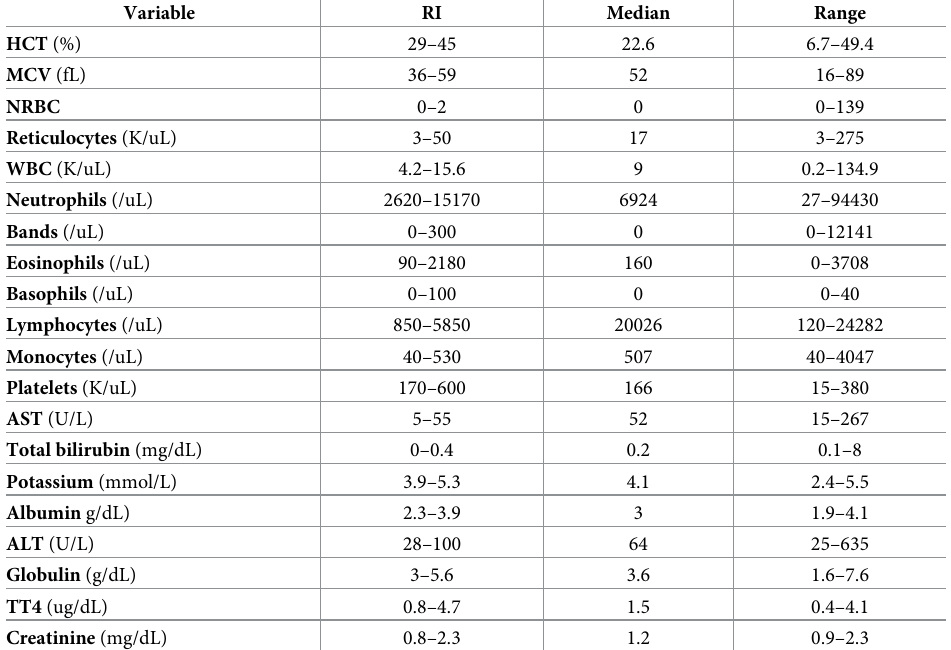
Table 2. Blood work findings of cats testing positive for FeLV.